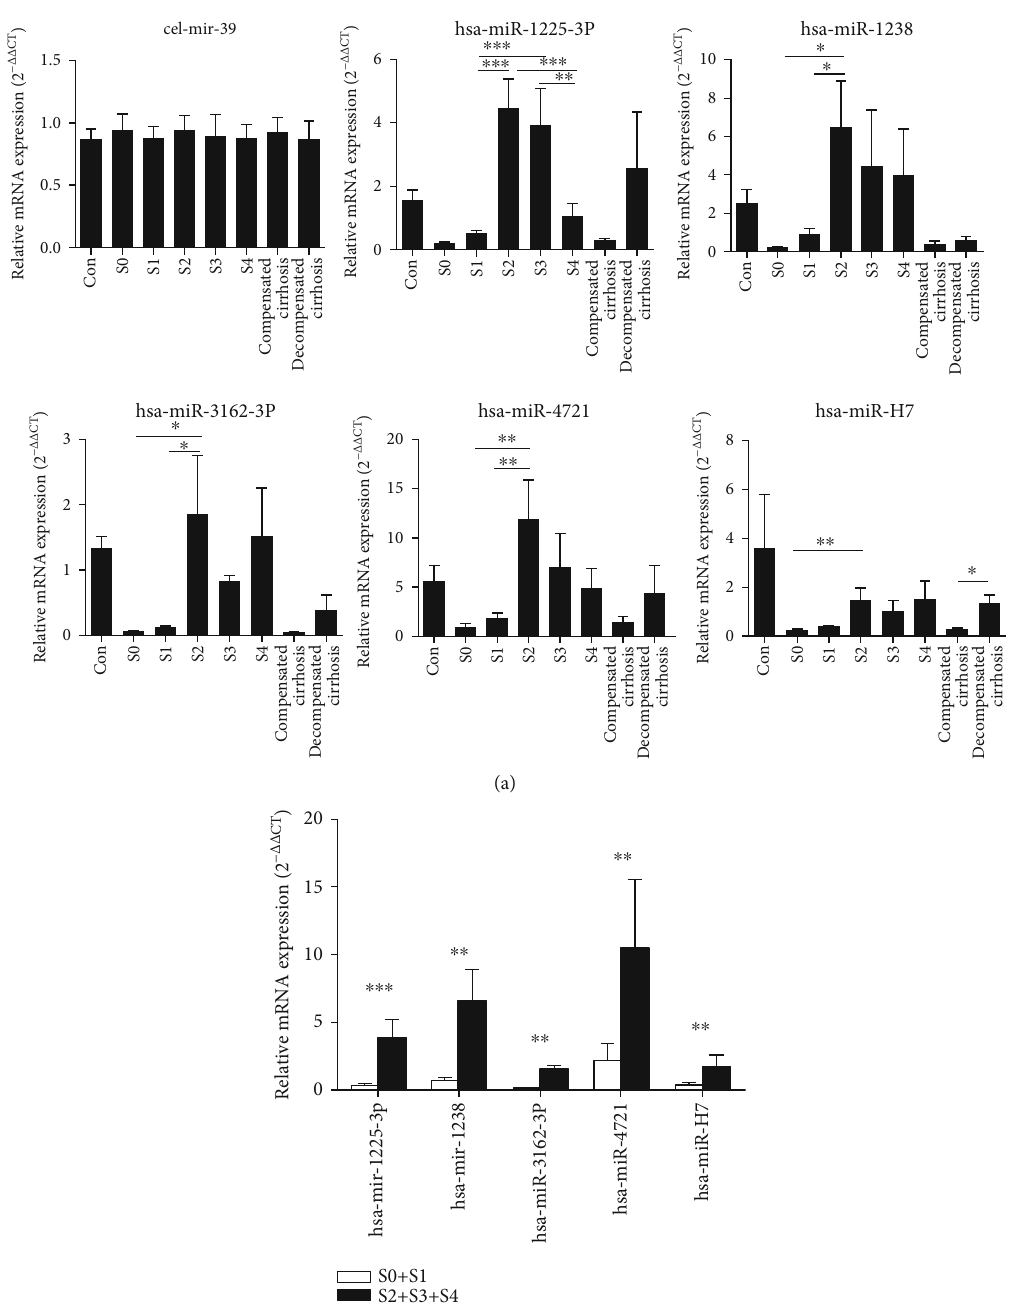
Figure 2: Relative mRNA expression level of di ff erent plasma microRNAs in cases of the chronic hepatitis B group and control group. (a) mRNA expression of hsa-mir-1225-3p, hsa-mir-1238, hsa-miR-3162-3P, hsa-miR-4721, hsa-miR-H7, and cel-mir-39 in normal control; CHB liver fi brosis S0 patients, S1 patients, S2 patients, S3 patients, and S4 patients; and CHB compensated cirrhosis patients and CHB decompensated cirrhosis patients. (b) mRNA expression of hsa-mir-1225-3p, hsa-mir-1238, hsa-miR-3162-3P, hsa-miR-4721, hsa-miR- H7, and cel-mir-39 in the CHB nonsigni fi cant liver fi brosis group (S0-1) and signi fi cant liver fi brosis group